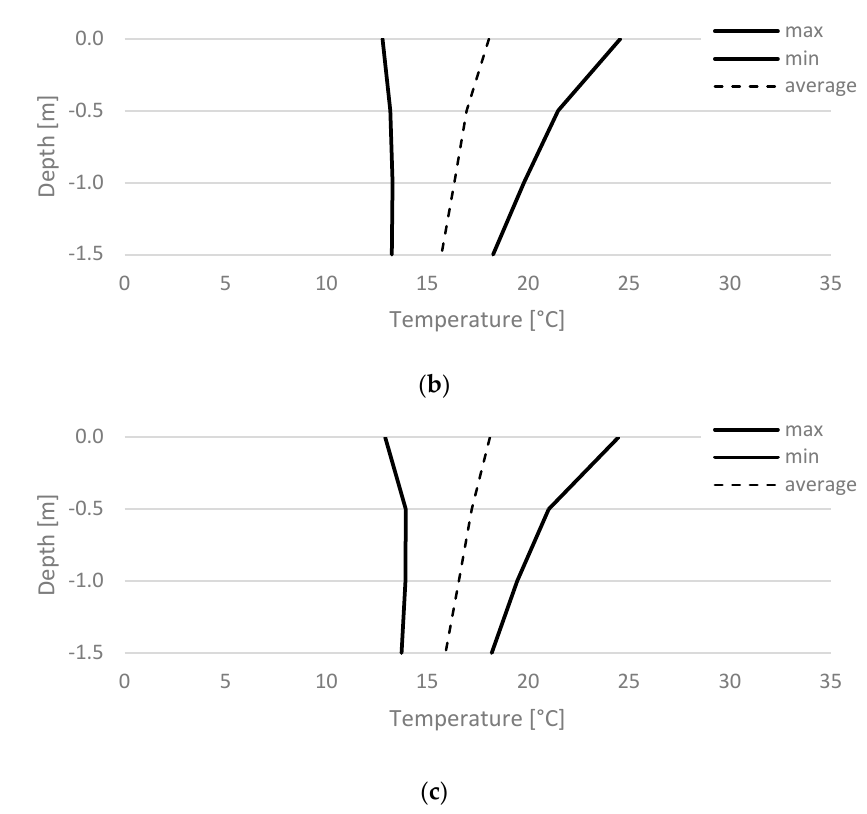
Figure 11. Fluctuation amplitude and average floor and soil temperature in variant 1; ( a ) measurement plumb I; ( b ) measurement plumb II; ( c ) measurement plumb III.